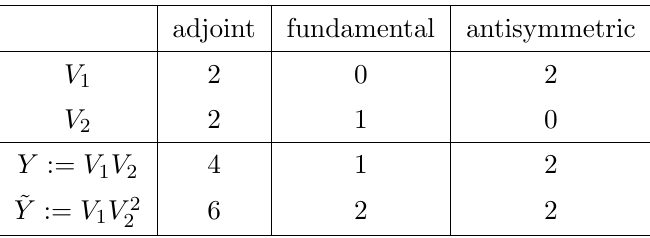
Table 7 . Fermion zero-modes for the USp(4) Coulomb